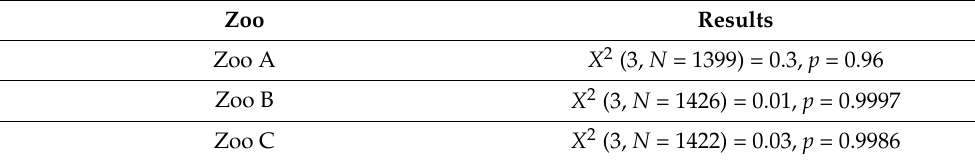
Table 5. 1 × 4 Chi-Squares for the Three